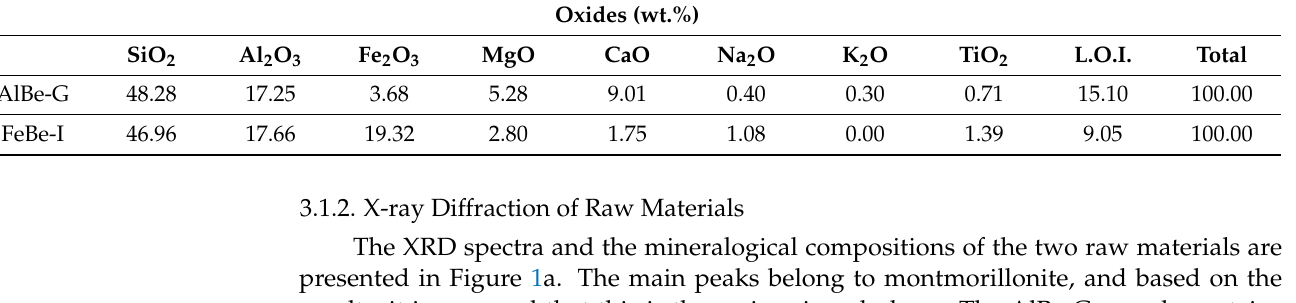
Table 1. Chemical Analysis of raw materials. Oxides